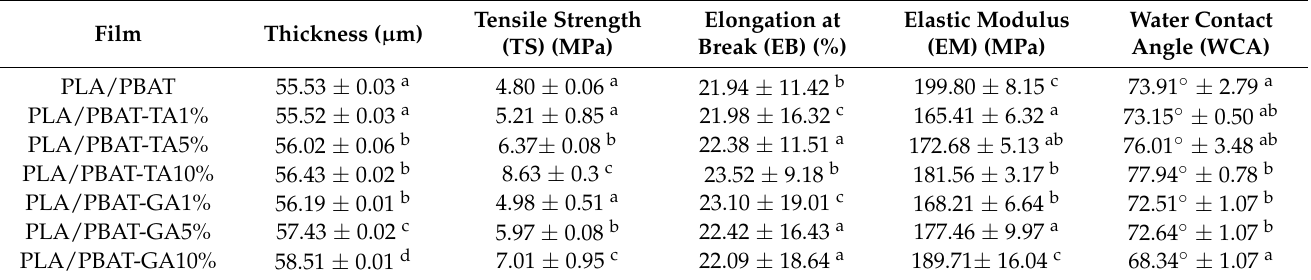
Table 2. Thickness, tensile properties, and hydrophobicity of the composite films with tannic acid and gallic